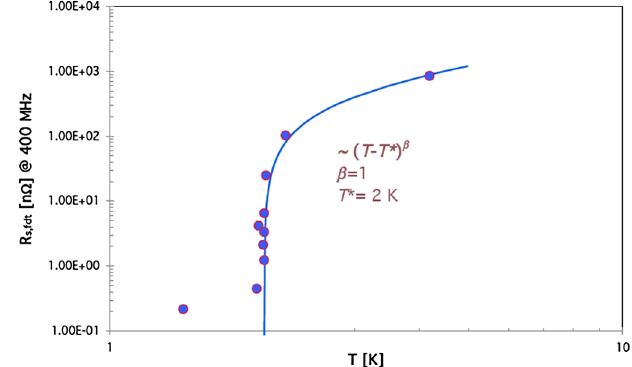
FIG. 4. The averaged temperature dependent part of the field- dependent surface resistance R s;fdt versus the bath temperature T (the error bars are smaller than the data points).